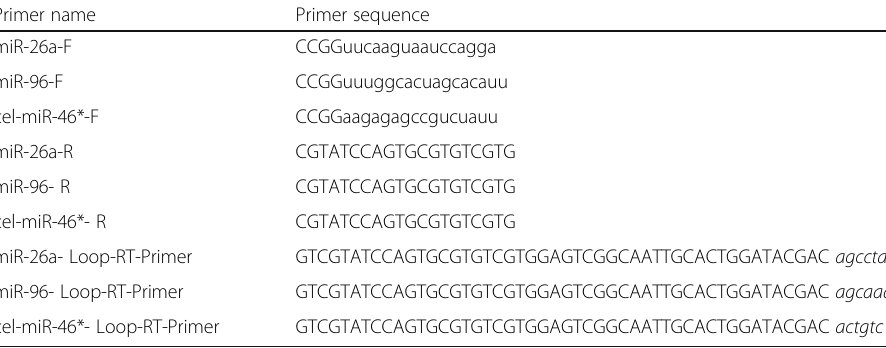
Table 1 Primers for detecting miR-96 and miR-26a based on the stemloop